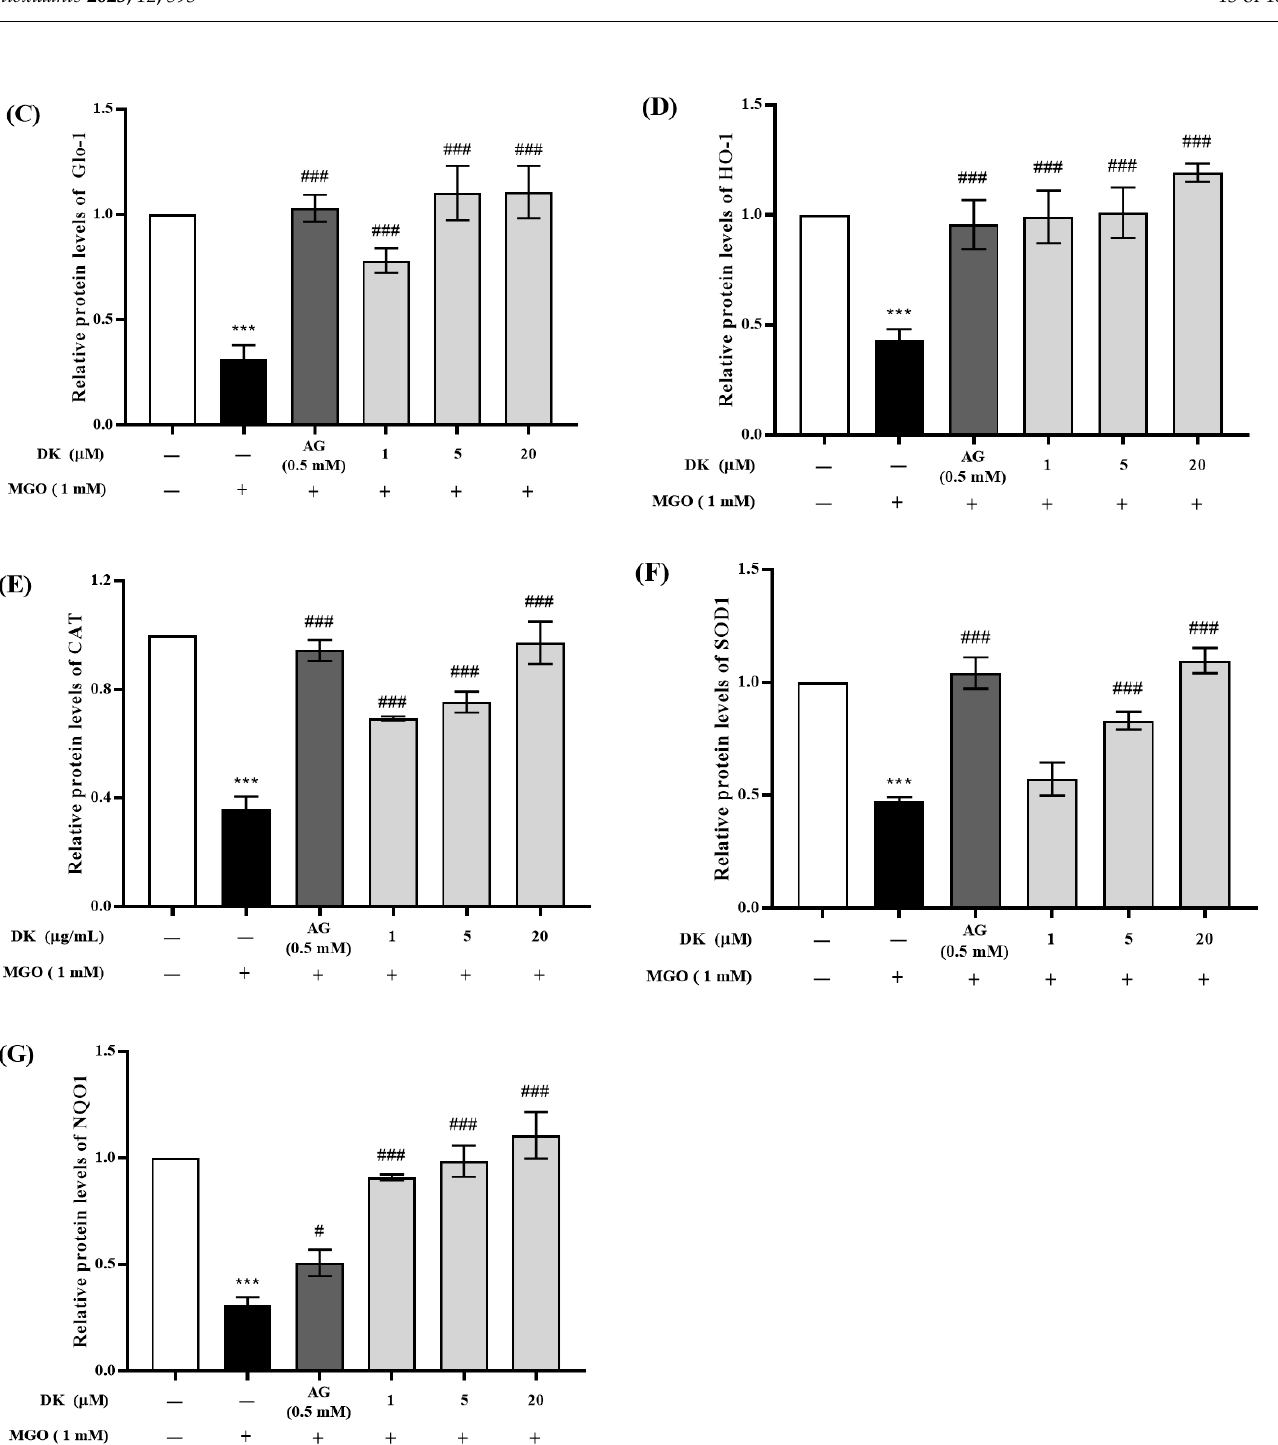
Figure 6. Effects of DK on Nrf2/Glo-1/ARE signaling pathway in mouse glomerular mesangial cells. Cells were pretreated with DK (1, 5, and 20 µ M) or AG (0.5 mM) for 1 h. Then, 1 mM MGO was added and incubated for 23 h. ( A ) The protein expression levels of Nrf2 and Nrf2 downstream molecules, such as Glo-1, HO-1, CAT, SOD1, and NQO1, were measured by Western blot; ( B – G ) bar graph showing the relative protein expression band intensity level of Nrf2, Glo-1, HO-1, CAT, SOD1, and NQO1. The bar values are presented as mean ± standard deviation ( n = 3) (*** p < 0.001 vs. nontreated cells and # p < 0.05, ### p < 0.001 vs. MGO-treated cells).